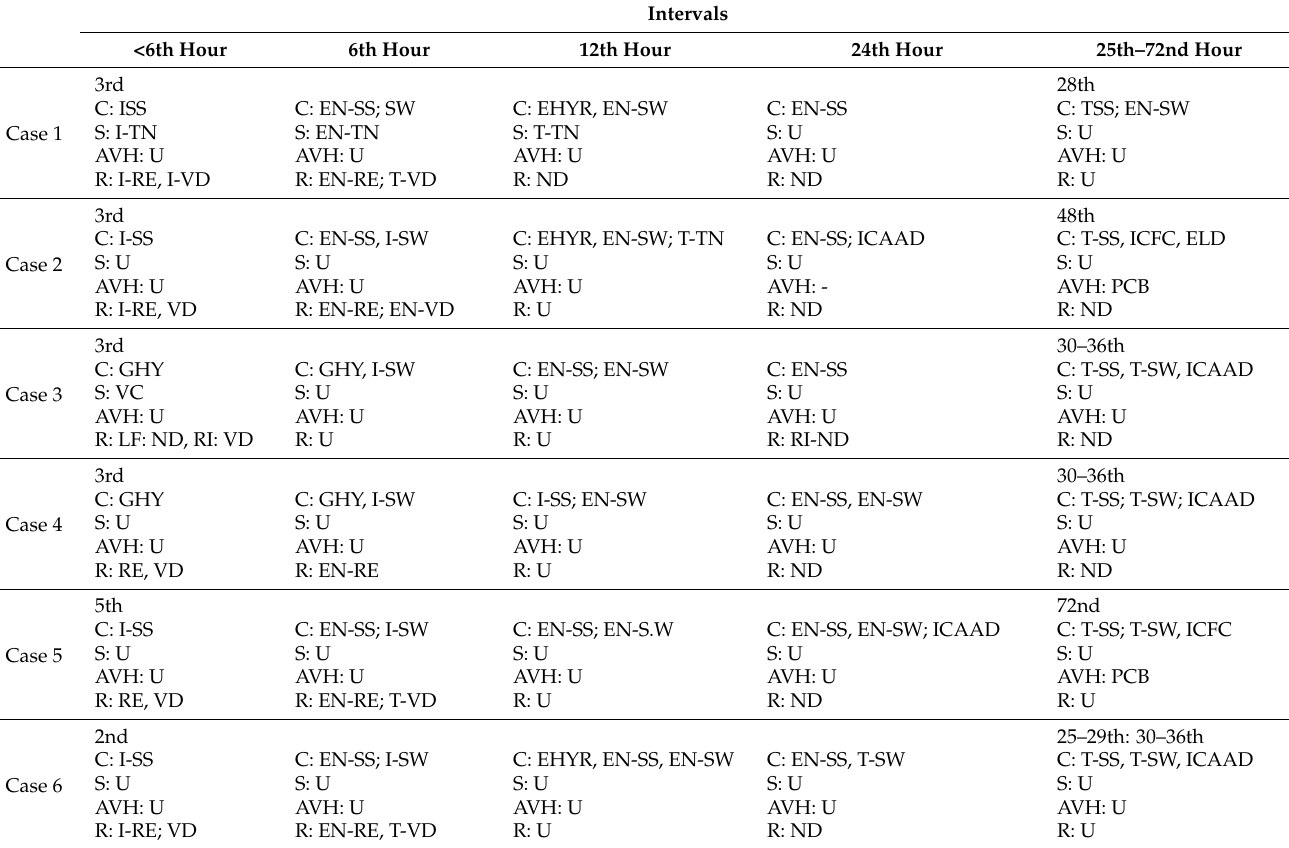
Figure 7. Retinal three-dimensional reconstruction in early postmortem intervals. Table 2. Morphological corneal alterations observed by